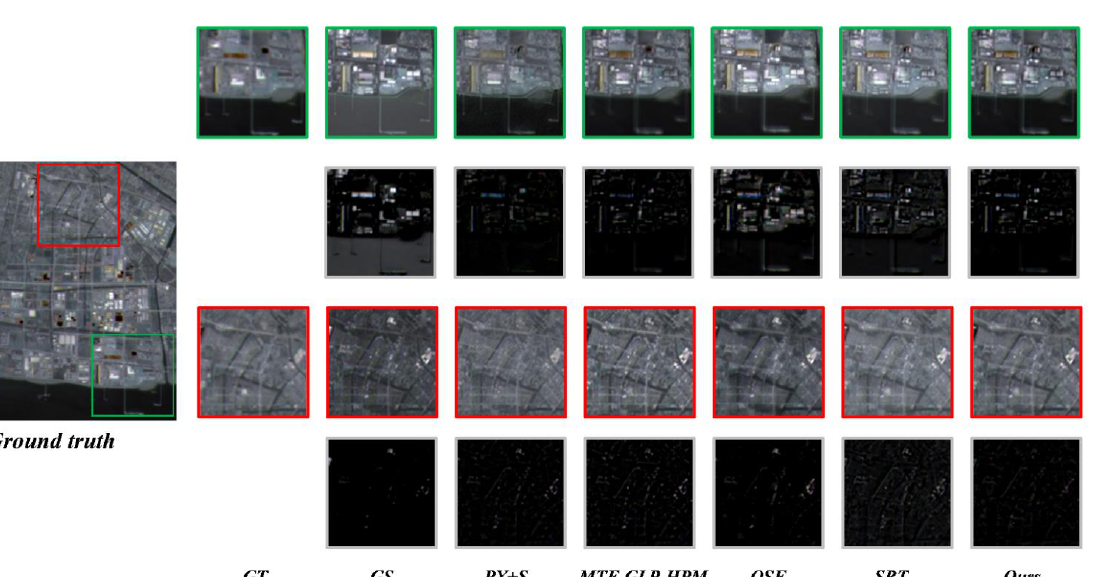
Figure 3. Comparison of fusion results of different algorithms on simulation data (the original image was taken in Beijing on 3 May 2022; scene: residential area).